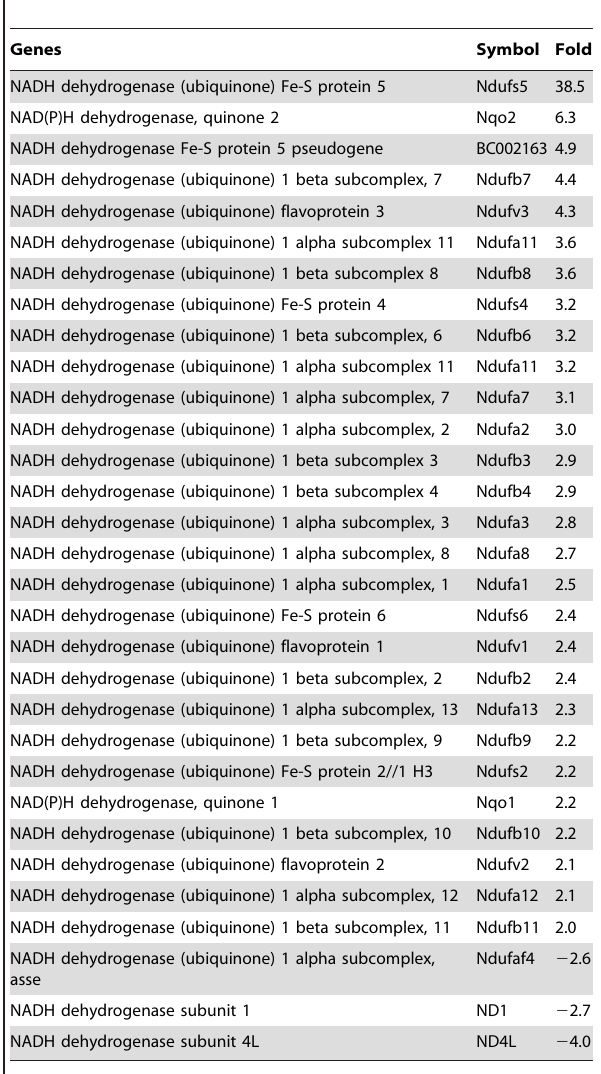
Table 13. Up-regulation of cytochrome and ATP synthesis subunits in lal 2 / 2 bone marrow